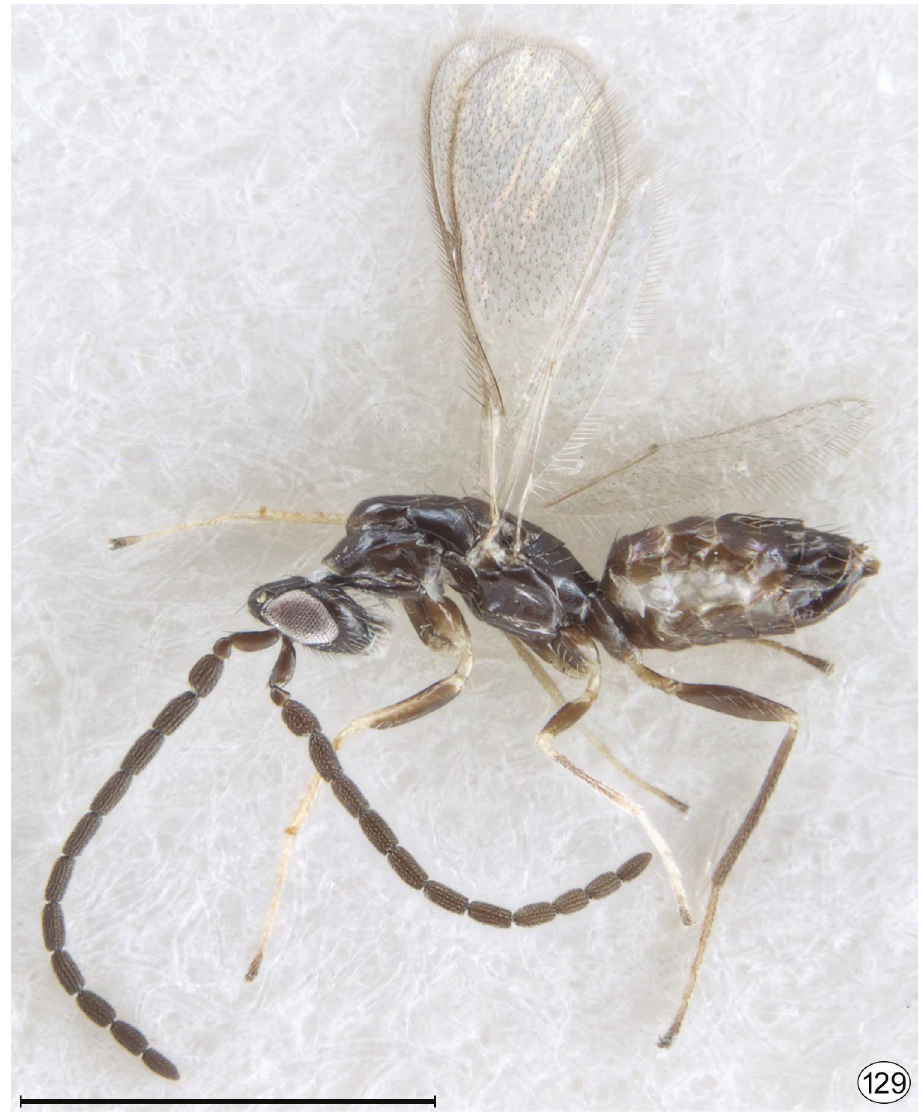
Figure 129. Neotriadomerus powerae , paratype male habitus, lateral (Brisbane Forest Park). Scale bar = 1000